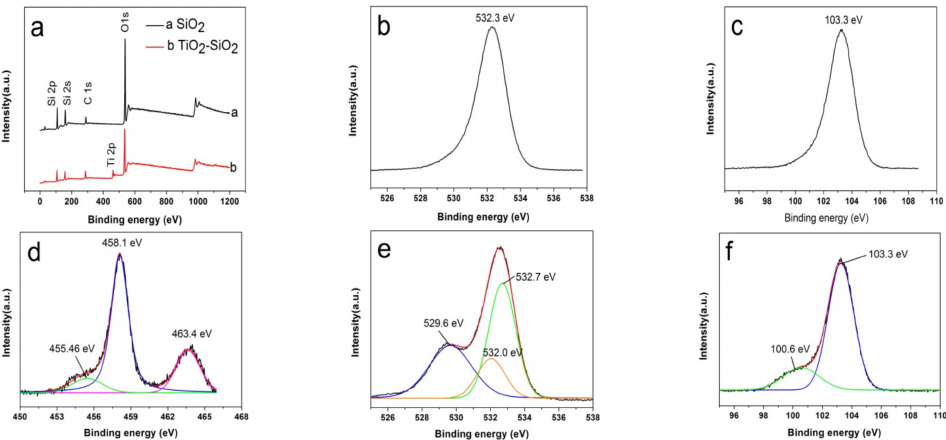
Figure 8. XPS spectra of SiO 2 and TiO 2 -SiO 2 . ( a ) Survey scan; ( b ) O 1s of SiO 2 ; ( c ) Si 2p of SiO 2 ; ( d ) Ti 2p of TiO 2 -SiO 2 ; ( e ) O 1s of TiO 2 -SiO 2 ; ( f ) Si 2p of TiO 2 -SiO 2